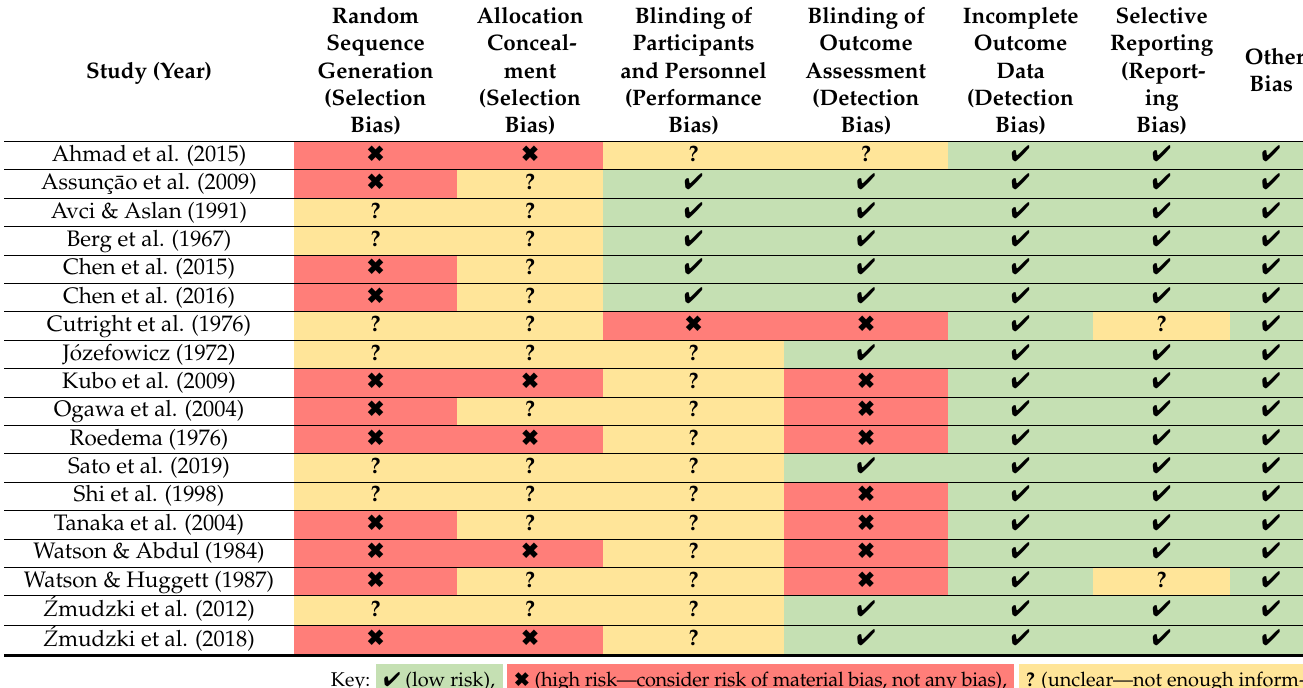
Table 2. Risk of bias summary.